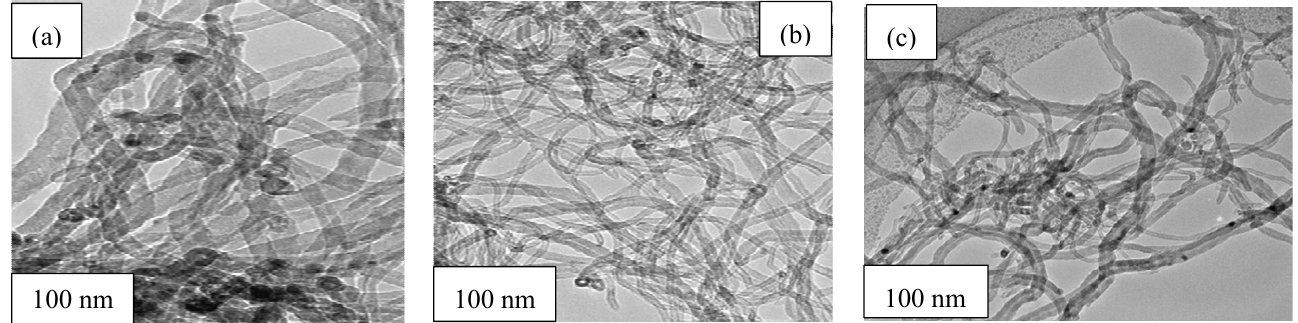
Figure 6. TEM micrographs of h -BN-CNT with ( a ) 20% silver ( b ) 20% iron and ( c ) 20% nickel before thermal treatment. used to detect the purity of the sample as shown. The mass-loss profile, thermogravimetric oxidation, and morphology were all analyzed. The TEM (JEM-Z200FSC) profile in Figure 6 shows three different h -BN-CNTs samples under three different catalysts. The h -BN-CNT sample with 20% silver is smoother less impure than the other two samples containing iron and nickel in the same concentrations. The Raman spectrum shown in Figure 7 is used to understand the full characteristic of the h -BN-CNT nanocomposite materials.